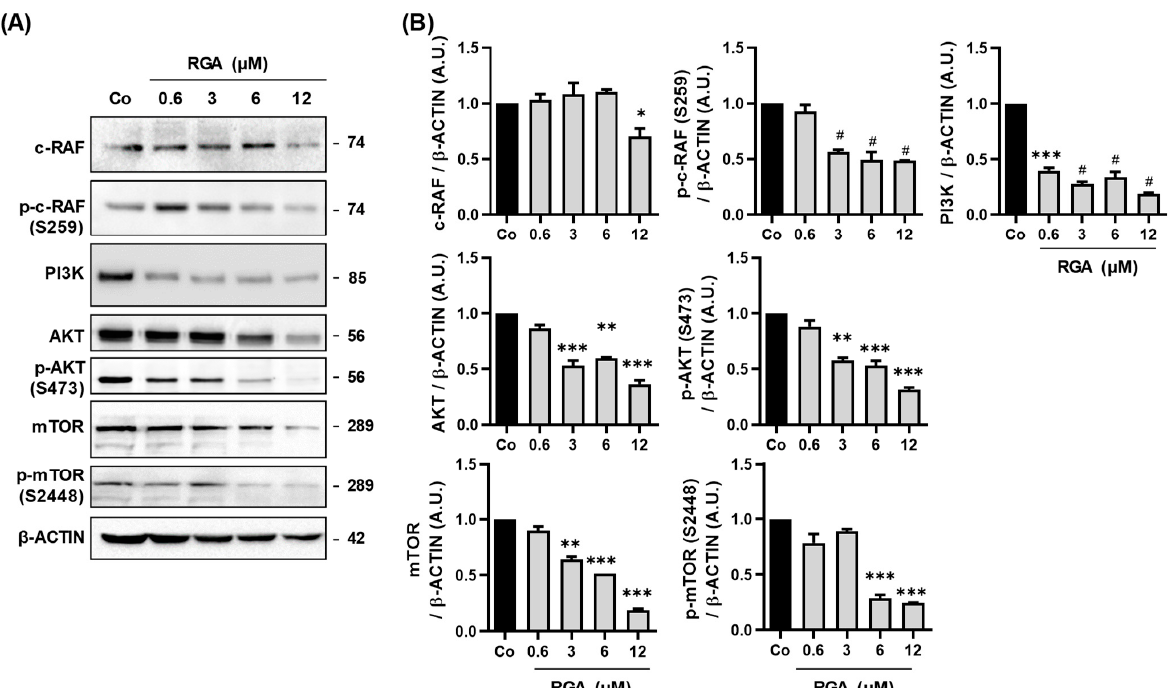
Figure 2. RSV/ ω‐ 3 fatty acids combination disrupts PI3K ‐ AKT ‐ mTOR signaling pathway. ( A ) Im ‐ munoblot analysis of c ‐ RAF, phospho ‐ c ‐ RAF (p ‐ RAF), PI3K, AKT, phospho ‐ AKT (p ‐ AKT), mTOR, phospho ‐ mTOR (p ‐ mTOR) in RGA ‐ treated ARPE ‐ 19 cells with increasing concentration (0.6, 3,